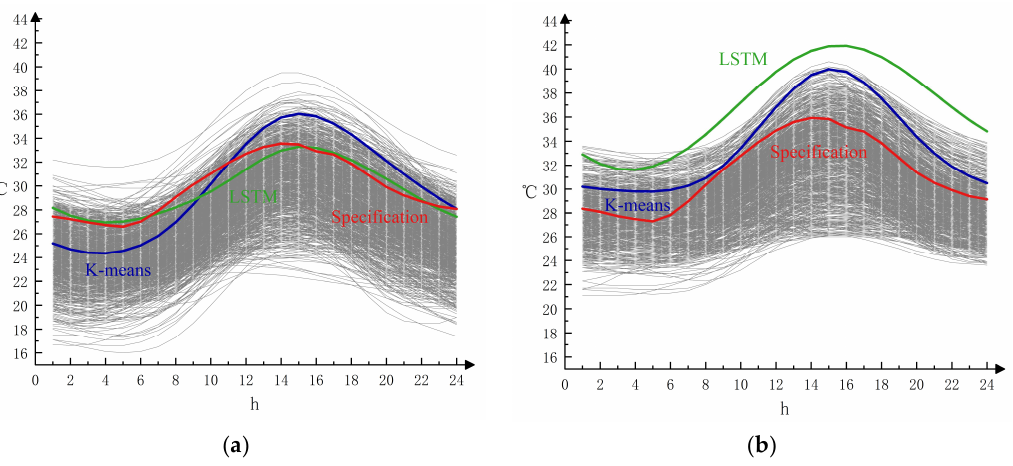
Figure 11. Comparison between Beijing ( a ) and Shanghai ( b ) design day and real value.